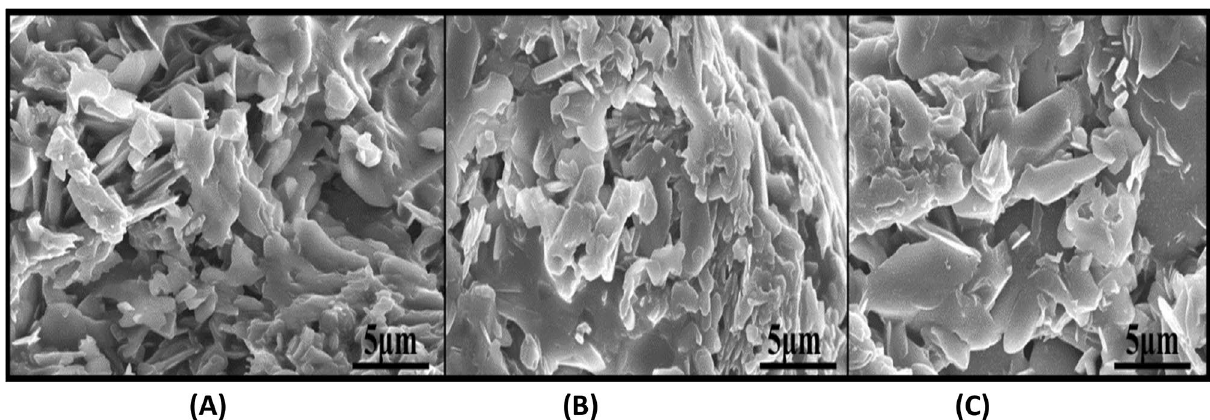
Figure 7. ( A – C ) SEM micrographs of AuNPs synthesized from the essential oil of C. flexuosus from diverse altitudes of ( A ) Palampur (AuS1), ( B ) Haryana (AuS2), and ( C ) Dehradun